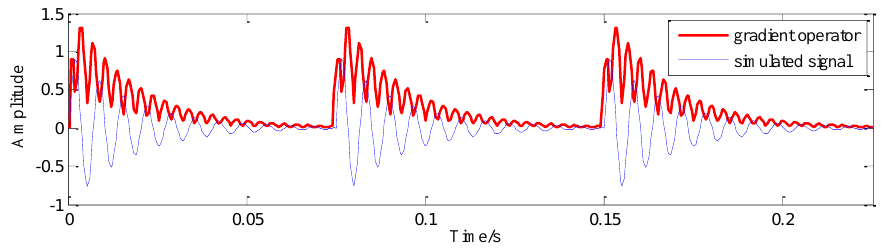
Figure 4. Filtering result of gradient operator.